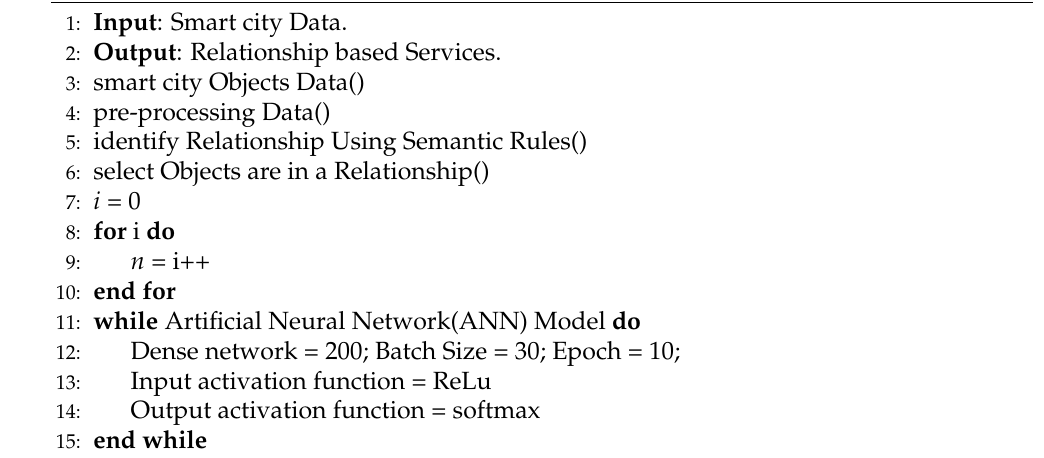
Algorithm 1 Proposed methodology of R-ANN knowledge model